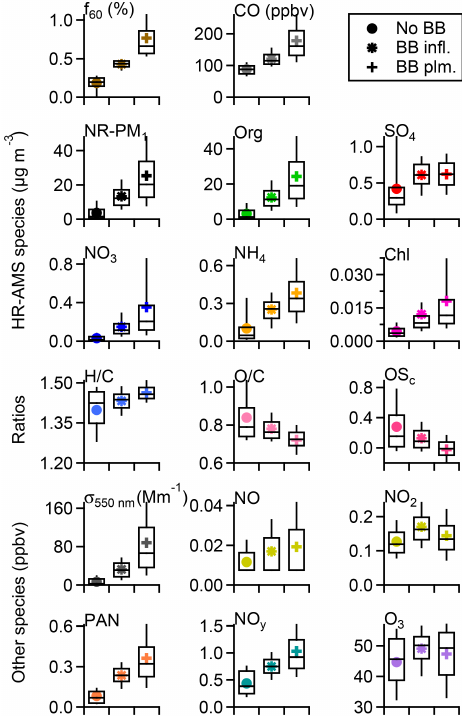
Figure 3. Box plots that compare f 60 values, CO mixing ratios, NR-PM 1 species concentrations, OA elemental ratios, carbon oxi- dation states (OS c ) , σ 550nm , and mixing ratios of trace gases among three aerosol regimes (No BB, BB Infl, and BB Plm). The whiskers indicate the 90th and 10th percentiles, the upper and lower bound- aries respectively indicate the 75th and 25th percentiles, the lines in the boxes indicate the median values, and the markers indicate the mean